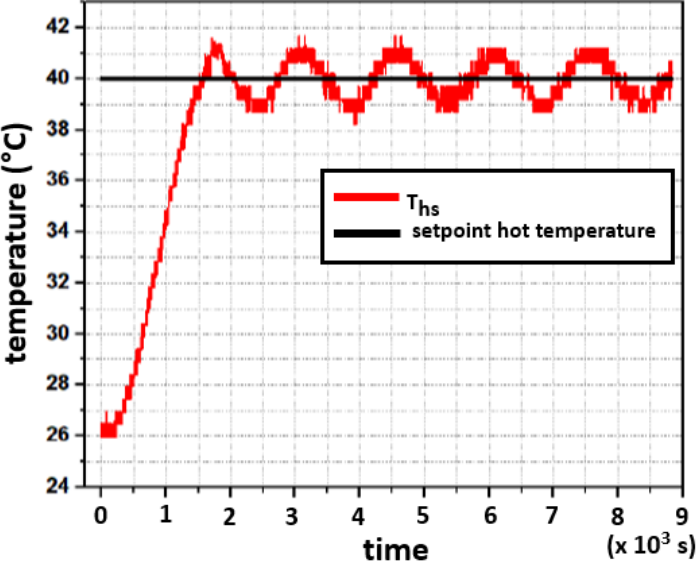
Figure 12. Experimental closed-loop response for the hot side. The setpoint is 40 ◦